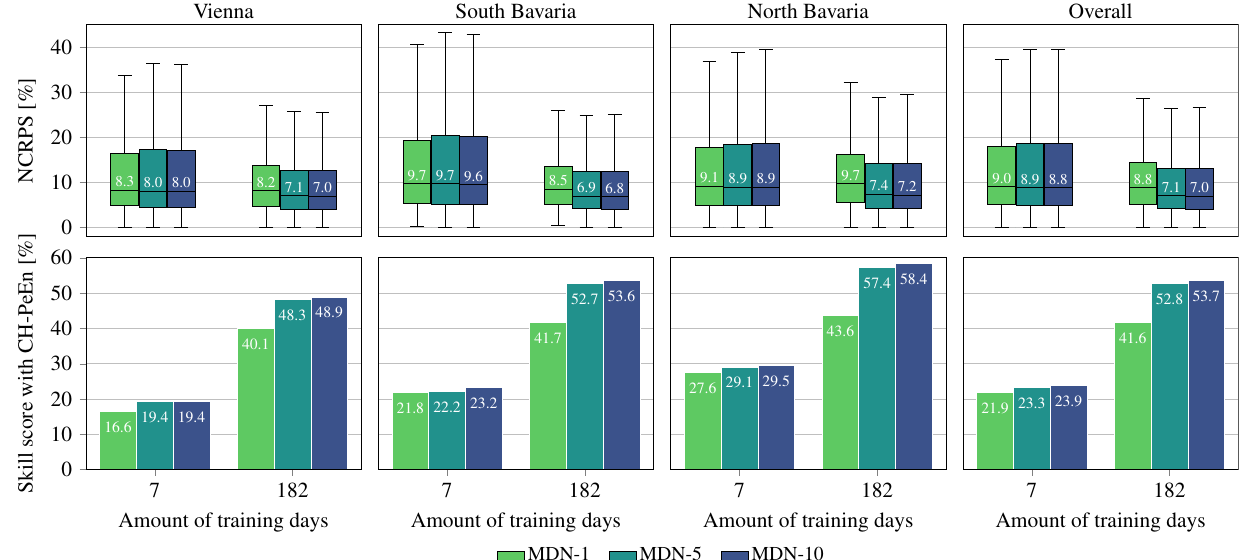
Figure 4. Accuracy of the probabilistic forecast for the different location and overall—for differ- ent amounts of available training data and different numbers of mixture distributions (top row). The comparison to the benchmark forecast CH-PeEn is also illustrated by the skill scores (bottom row). The results are based on a forecast horizon of 6 h and MDN ensembles with 15 training initializations, which in turn have 15 dropout ensembles each. The number after the abbreviation MDN in the legend indicates the respective distribution quantity, e.g., MDN-1 means one output distribution. The whiskers in the box plot span 1.5 times the interquartile range, which extends from the 25th to the 75th